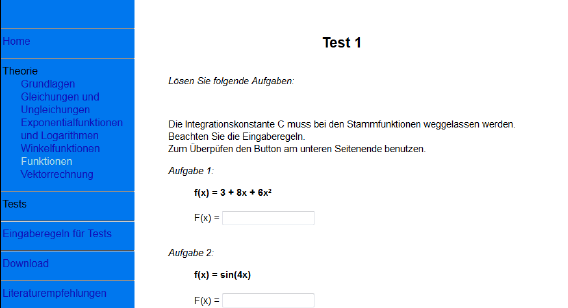
Figure 3. Online-cloze test on the learning platform